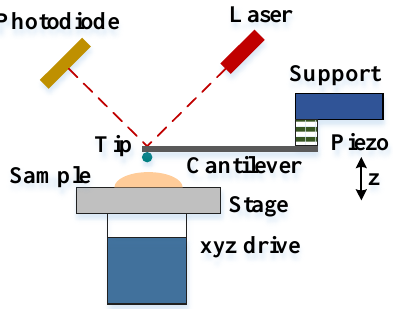
Figure 4. Schematic diagram of an AFM instrument.